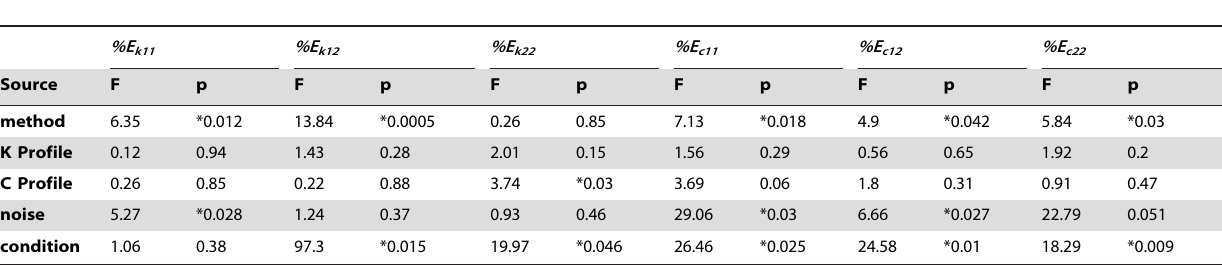
Table 3. Repeated measures ANOVA among estimation methods with stiffness and damping time-profiles as random factors along the interval 2.6–3.175